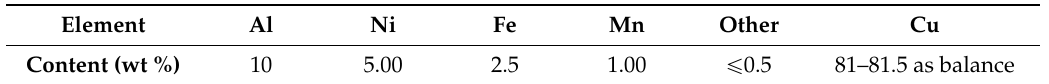
Table 1. Chemical composition of AMPCO 45.